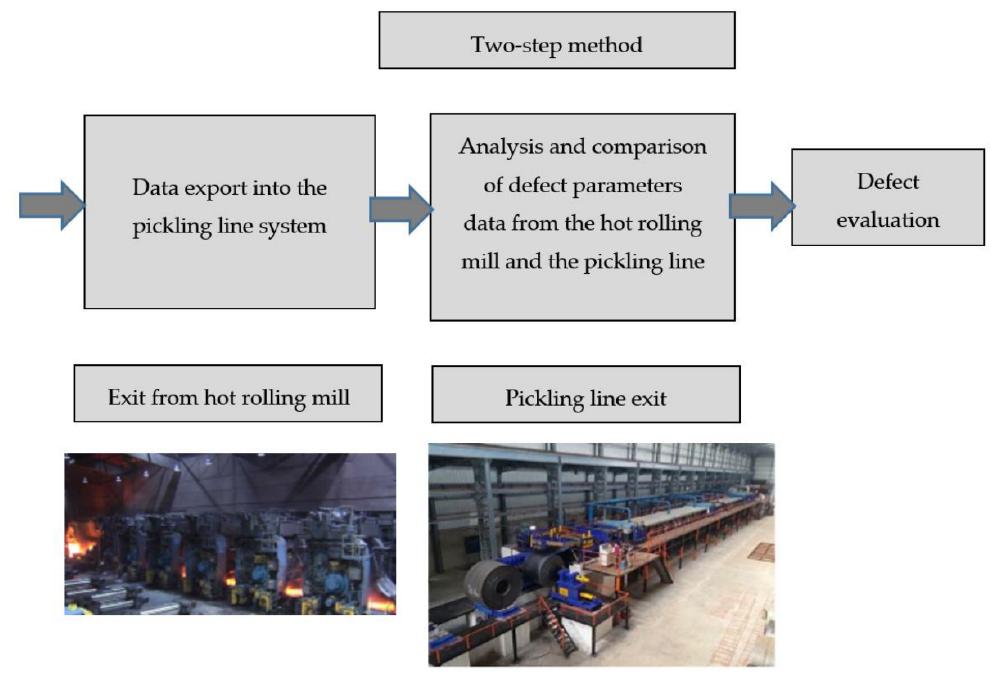
Figure 12. Double-step defect evaluation method chart.